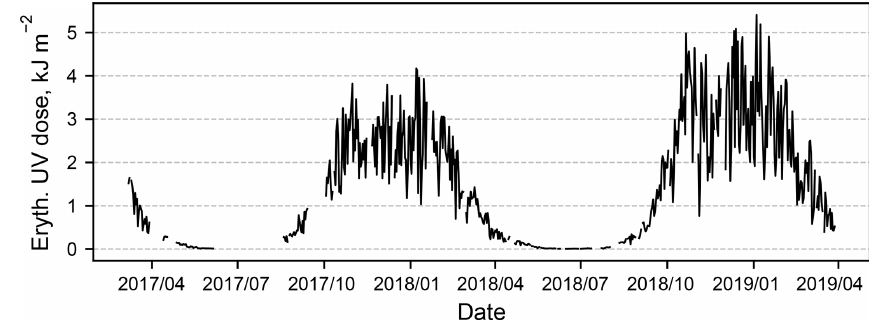
Figure 3. Daily erythemal UV doses in Marambio from March 2017 to March 2019.